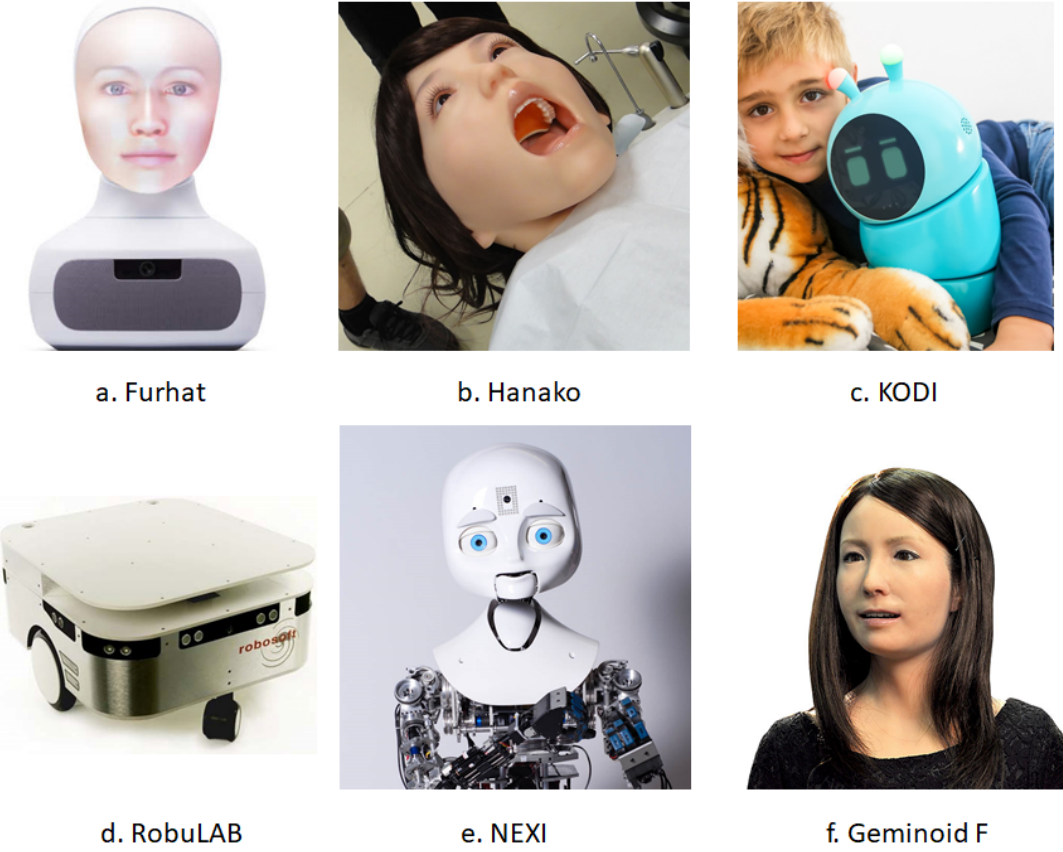
Figure 2: Social robots examples: a. Furhat, b. Hanako, c. KODI, d. RobuLAB, e. NEXI, f. Geminoid F.